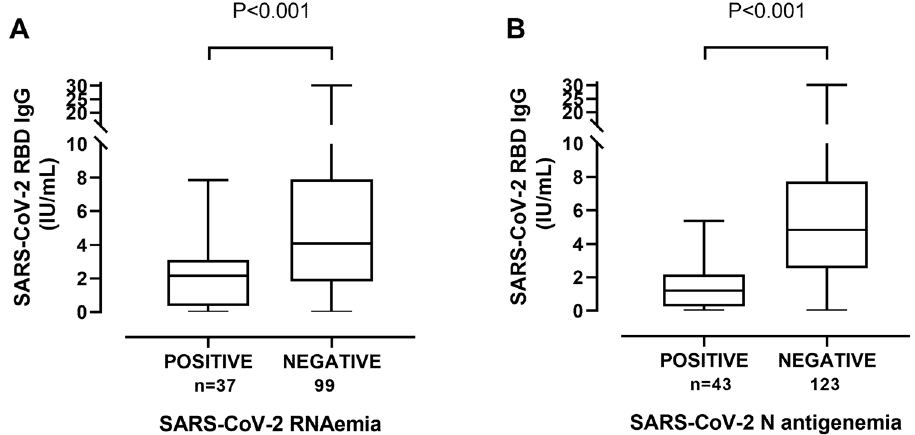
Figure 2. Box-plot depicting anti-SARS-CoV-2-S (RBD) antibody levels in plasma according to presence or absence of virus RNAemia ( A ) or N-antigenemia ( B ). P values are shown for comparison.